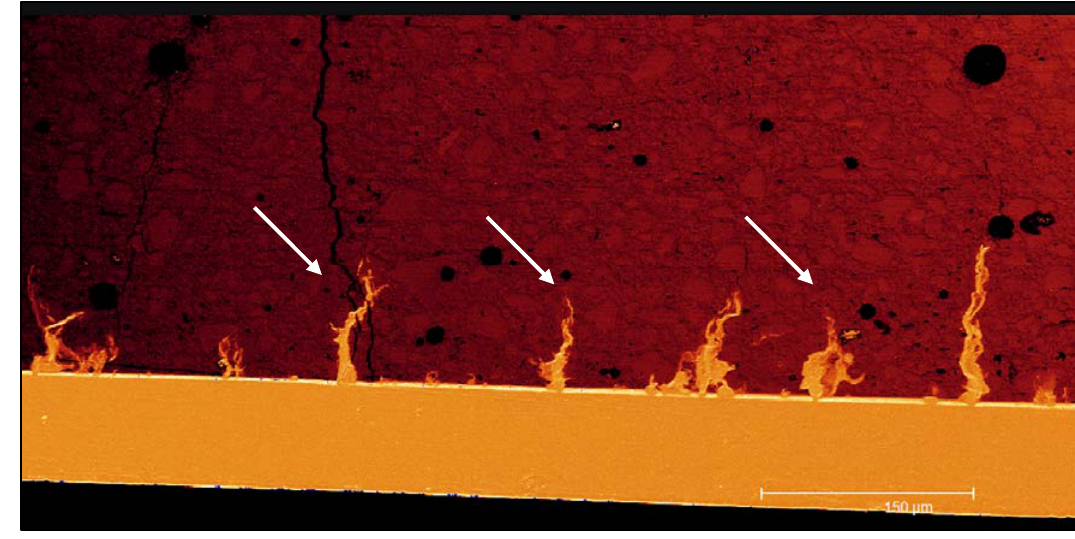
Figure 6. CLSM images of a resin coating layer on GIC. The complete sealing of surface porosities and dehydration cracks (arrows) is observable under fluorescent